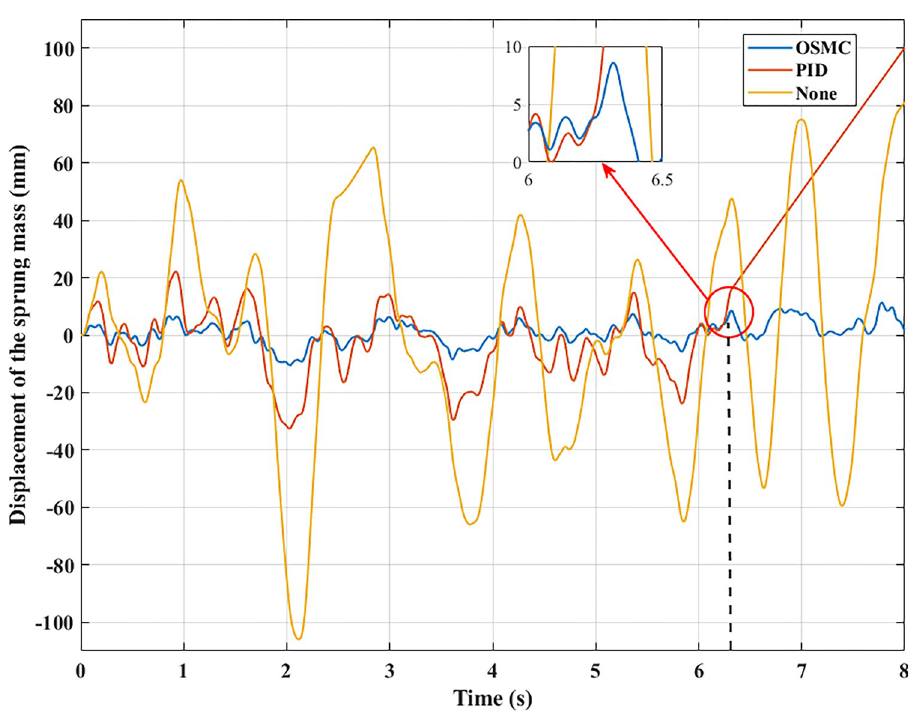
Fig 7. Displacement of the sprung mass (case 3).